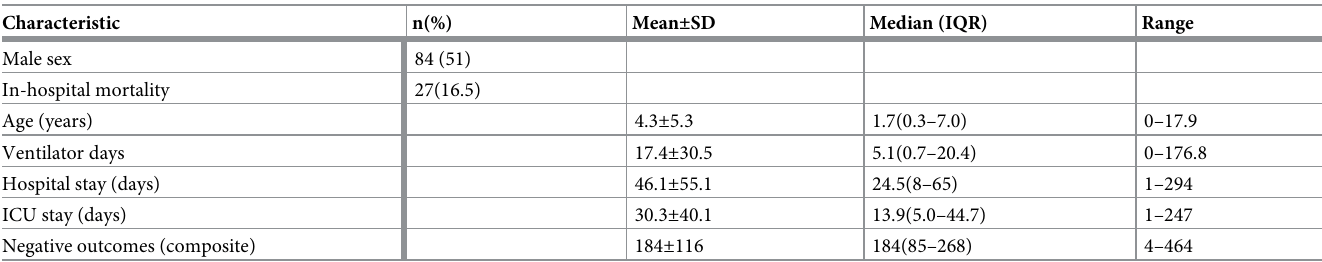
Table 1. Characteristics of the study population.